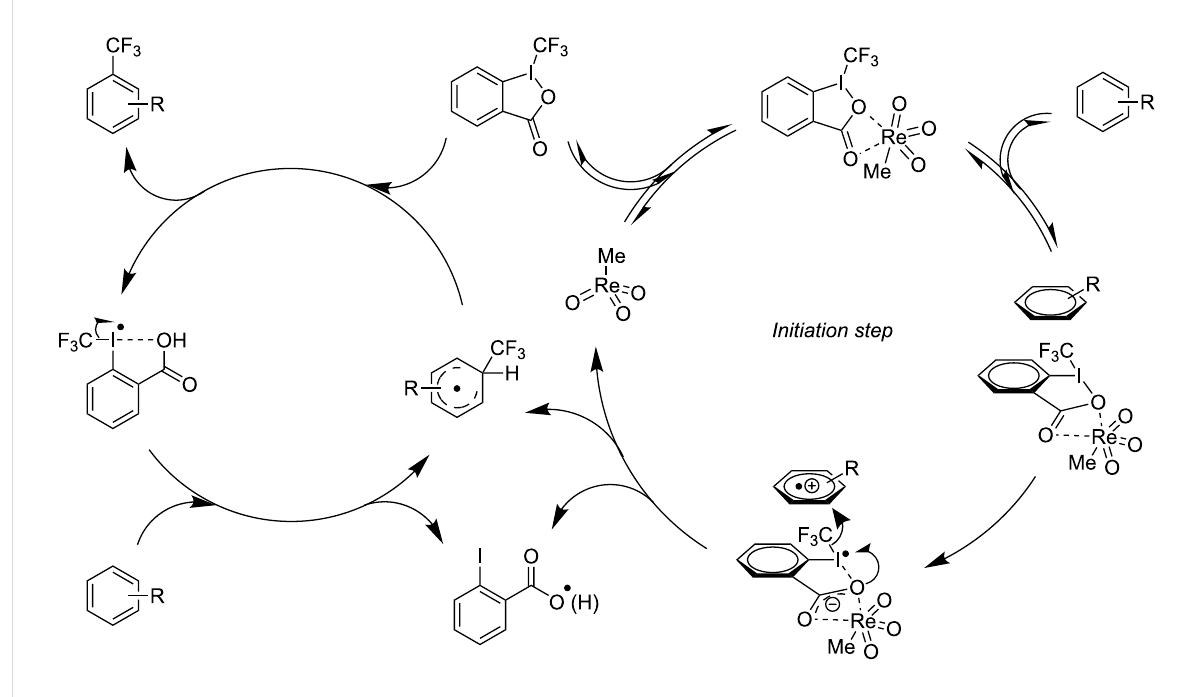
Figure 21: Mechanistic proposal by A. Togni et al. for the rhenium-catalyzed trifluoromethylation of arenes and heteroarenes with hypervalent iodine reagents [113].